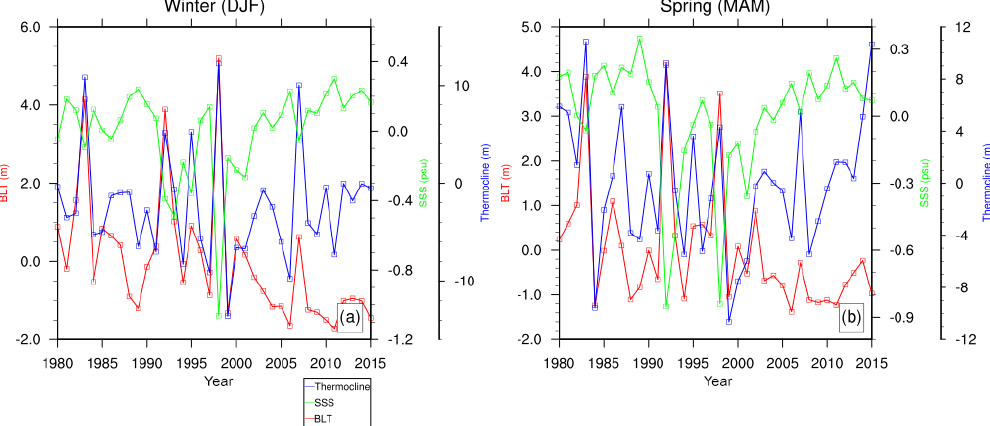
Figure 12. Time series of BLT, SSS, and thermocline anomalies averaged over the western TIO (12 ◦ S–5 ◦ N, 55–75 ◦ E) during boreal winter (a) and spring (b) from 1980 to 2015. Red, green, and blue lines represent BLT, SSS, and the thermocline depth,